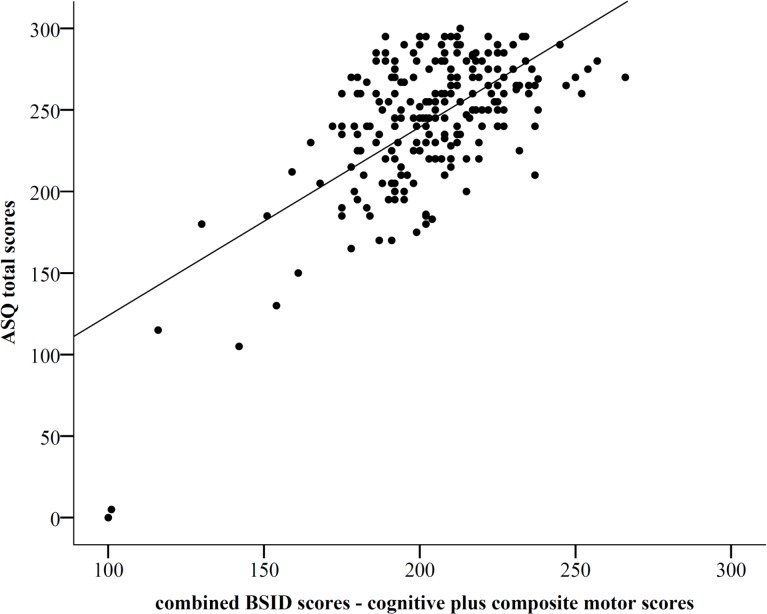
Correlation between BSIDIII combined cognitive and composite motor scores and ASQ3 total scores.R square is 0.417, p<0.001. Incomplete BSID scores due to CP or severe mental impairment were imputed at 50 and incomplete ASQ scores were imputed with 0 points per item without a valid score.